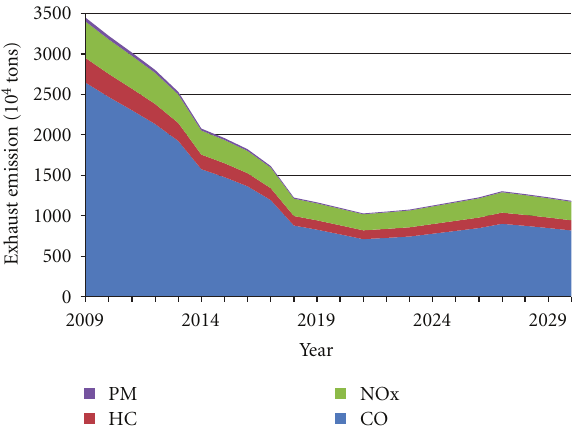
Figure 7: Forecast curve of China’s exhaust emissions in Scenario